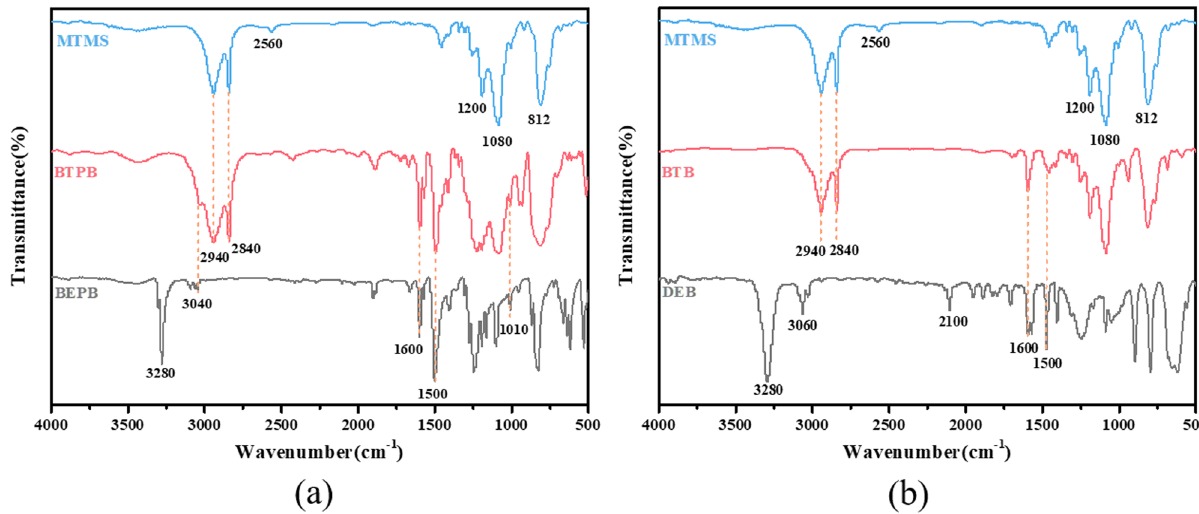
Figure 2: FT - IR spectra of MTMS, BTPB, and BEPB ( a ) and MTMS, BTB, and DEB ( b )